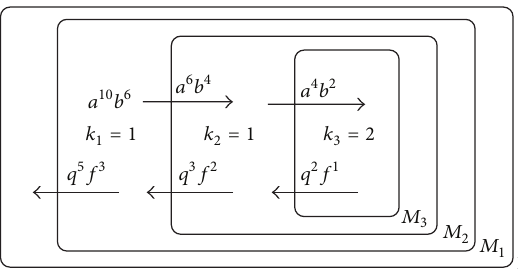
Figure 3: Schematic diagram for reducing 6/10 by the P